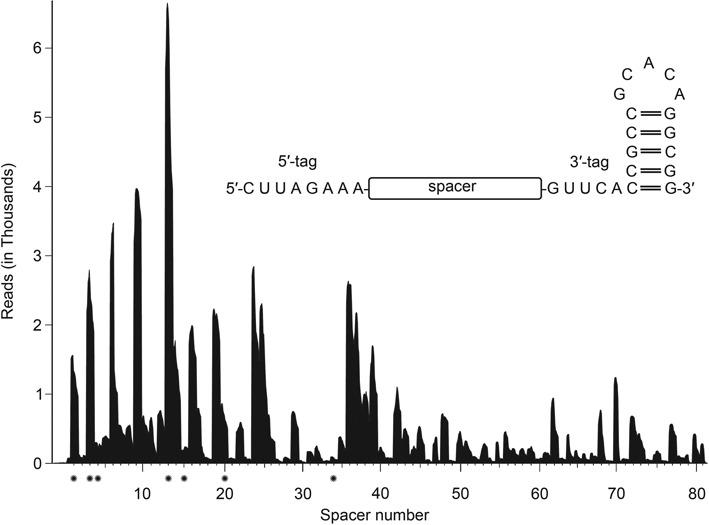
Analysis of CRISPR RNA abundance and termini. The coverage plot of S. putrefaciens CN-32 sequence reads (Illumina HiSeq2000) indicates the variable abundance of individual crRNAs. Mature crRNAs contained 5′-terminal 8 nt tags (5′-CUUAGAAA-3′) and 20 nt 3′-ends without further trimming events (inset). Spacers that are marked with an asterisk were tested for interference activity (see Figure 4)